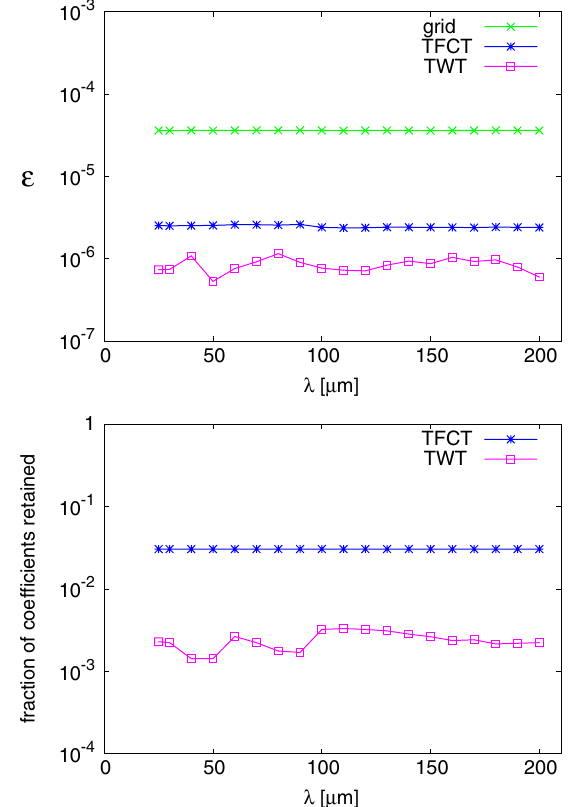
FIG. 11. Top: Accuracy of the approximation to the modulated flattop distribution (measured by the IMSE) as a function of the modulation wavelength (cid:8) for: grid (green); FCT on a grid (blue); and grid with wavelet denoising, using Daubechies wavelets of order 10 (purple). The parameters are given in Table III, and keep the number of particles per cell constant. Bottom: Sparsity of the two approximations—number of coefficients in the ex- pansion divided by the number of grid points—for the two representations: TFCT (blue) and TWT (purple).